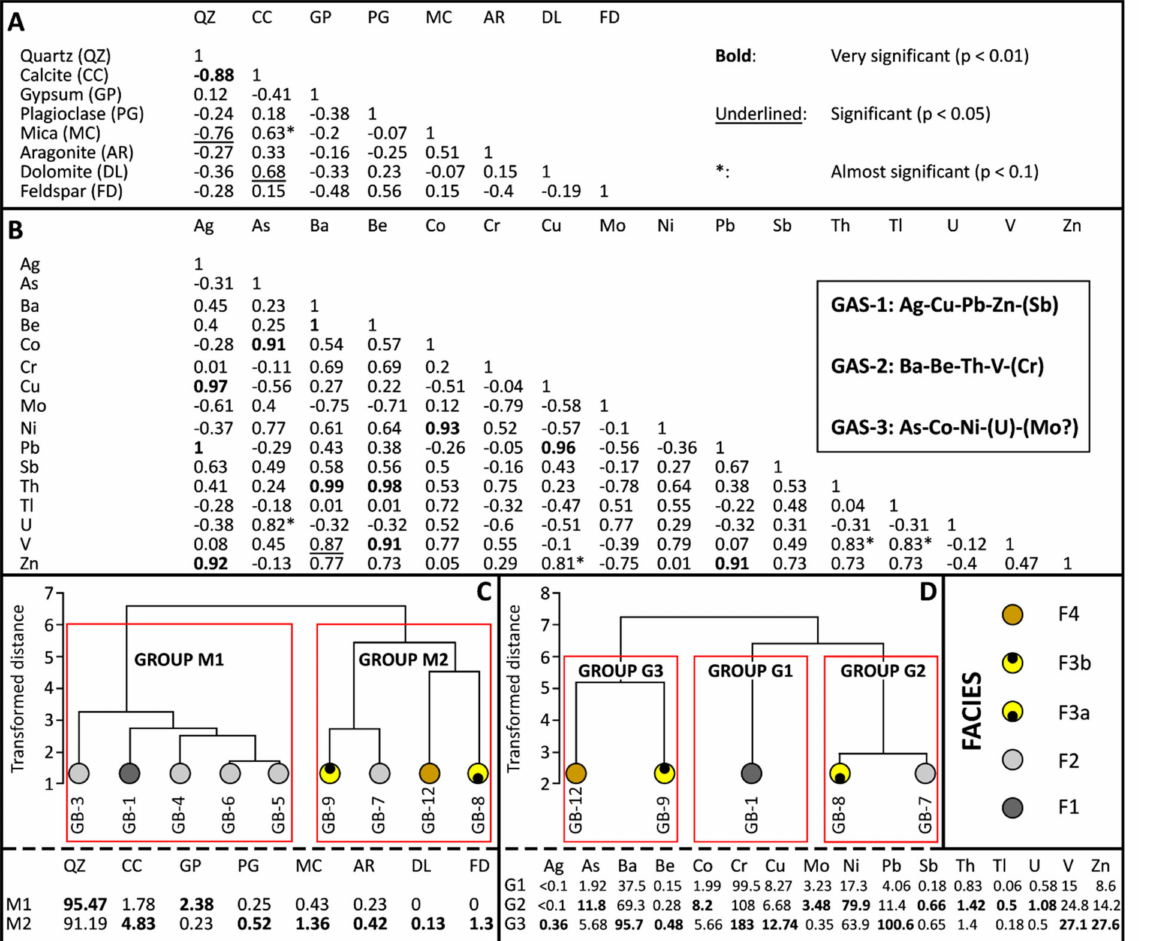
Figure 4. Statistical analysis. ( A ) Mineralogy: linear correlation; ( B ) geochemistry: linear correlation; ( C ) mineralogy: cluster analysis; ( D ) geochemistry: cluster